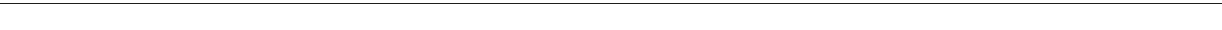
Fig. 3 Qualitative Network Model of the wider ion channel regulatory network. a , b Schematic of the network of ion channels involved in the model ( a ). Included are modules that involve osmotic regulation, calcium signalling, metabolism, and pH maintenance. Modules interact with each other heavily, and in particular osmotic regulation proteins are involved in many other modules. The schematic includes general trends of interactions, and does not show all nodes for completeness, but attempts to show the major protein types involved in each module, and the ionic behaviours considered. Individual nodes, however, can be much more complex than represented in the schematic, one example is shown in ( b ) of the Na-K-ATPase. In this case the Na-K-ATPase is split into two nodes, one representing the ion transport domain, and one representing the structural interactions of the domain. Both nodes interact with each other as they are part of the same protein, but subunits that associate in the protein complex elicit different effects. FXYD6 in fl uences the ion transport domain only, whereas FXYD5 in fl uences both the ion transport domain, and the structurally connected beta subunit domain, which interacts with the cytoskeleton and cell matrix independently of transport function. This separation of functional subdomains of the protein can also be used to incorporate phosphorylation states of the protein, where two nodes represent an unphosphorylated and phosphorylated state of the same